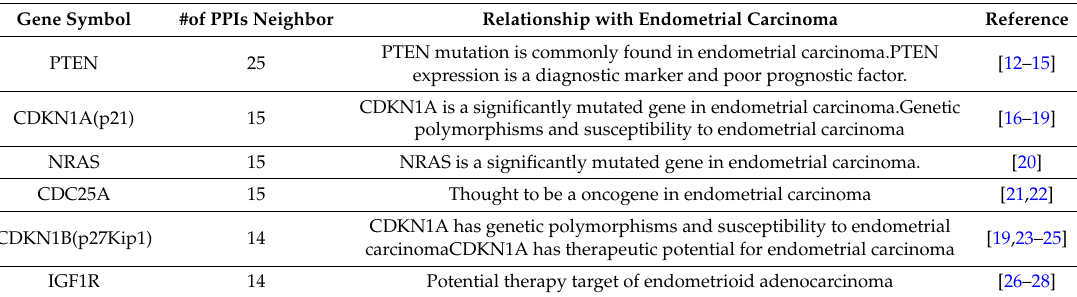
Table 2. Literature survey of initial endometrial carcinoma-related genes.